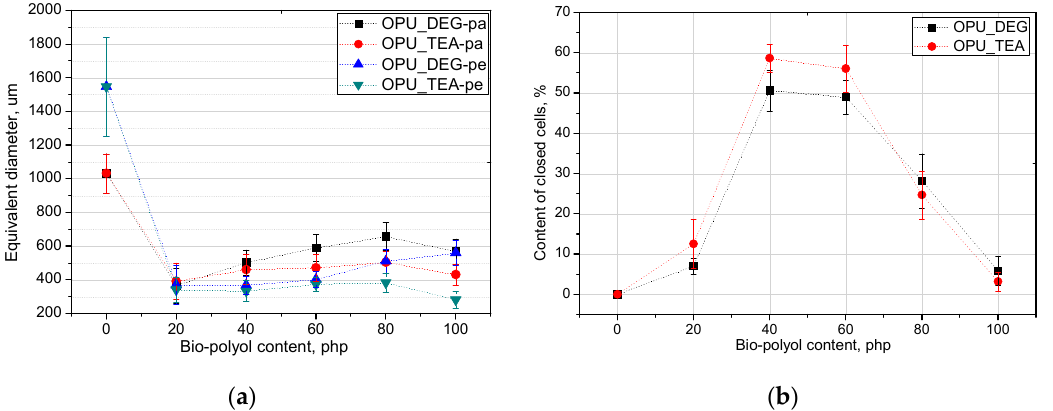
Figure 4. Equivalent diameter ( a ) and closed cell content ( b ) of bio-foams altered with bio-polyols in different amounts.